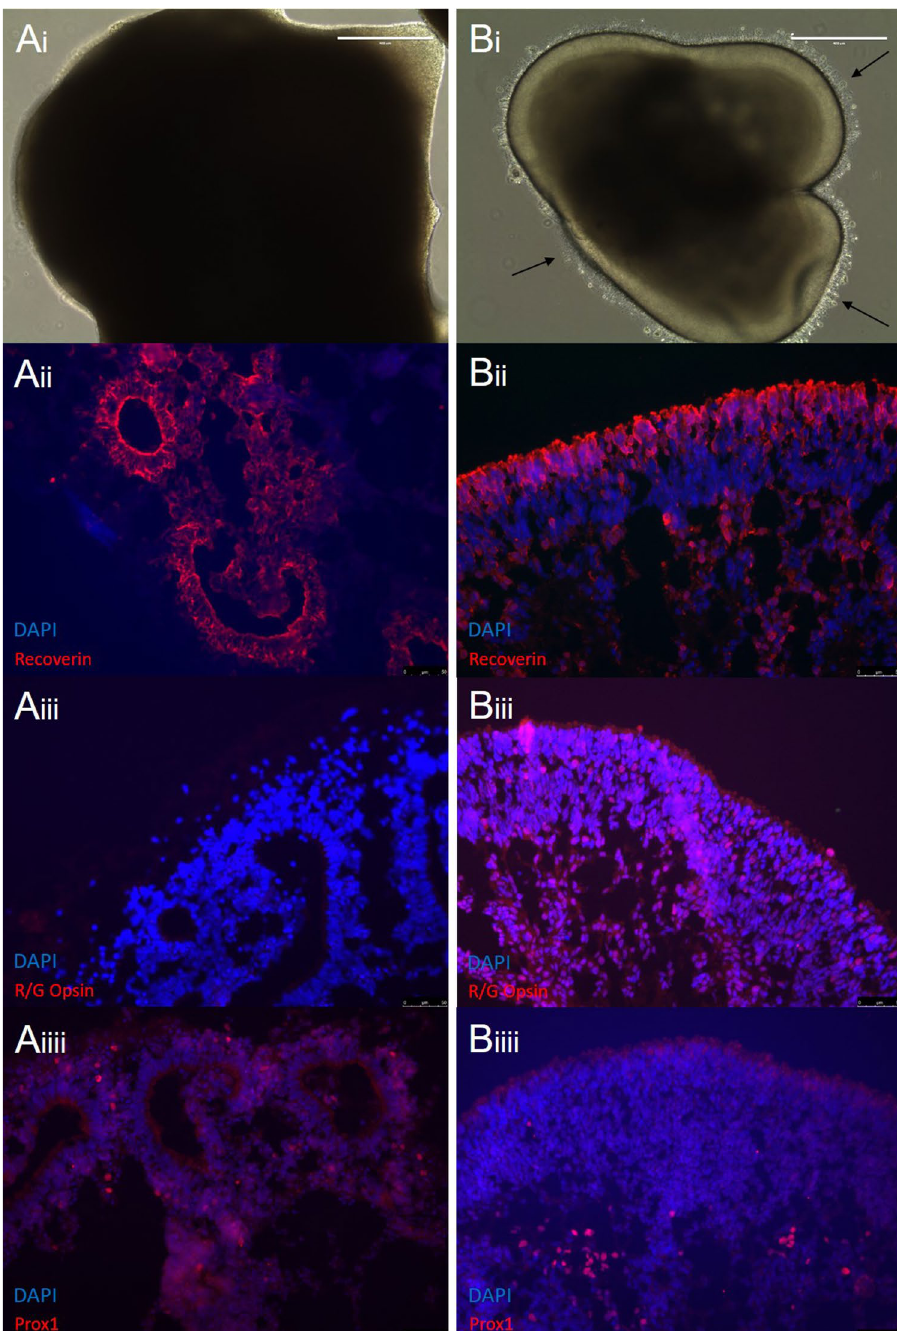
Figure 6. Long term lamination of retinal organoids. Organoids were either ‘treated’ by the addition of the external factors FBS, Taurine, RA or T3, or left ‘untreated’ in standard RDM. A comparison between long term cultures of untreated ( Ai – Aiii ) and treated ( Bi – Biii ) retinal organoids showed significant differences. ( Ai ) Untreated organoids appear extremely dark and dense, and contain photoreceptor rosettes. ( Bi ) Treated organoids retain their golden outer layer, and develop photoreceptors outer segments (black arrows) (Scale bars = 400 µm). ( Aii ) Photoreceptors develop within defined rosettes on the outermost part of the untreated organoid, shown by staining with the photoreceptor progenitor marker, RCVRN (in red). ( Bii ) Treated organoids contain an outer layer of photoreceptors surrounding the organoid, shown by RCVRN (in red). ( Aiii ) Untreated organoids also do not develop Red-Green cones by Day 160, suggested by lack of RNA expression and IHC staining. ( Biii ) The addition of T3 in the treated organoid cultures stimulated the development of Red- Green cone photoreceptors. ( Aiiii ) Although having lost the lamination of the organoid and developing rosettes, untreated organoids did still develop other cells around the rosettes, such as horizontal cells, found at the bottom of the photoreceptors. ( Biiii ) Treated organoids retain an multi-layered appearance, with photoreceptors on the outer edge of the organoid, and other cells positioned below as found in the in vivo